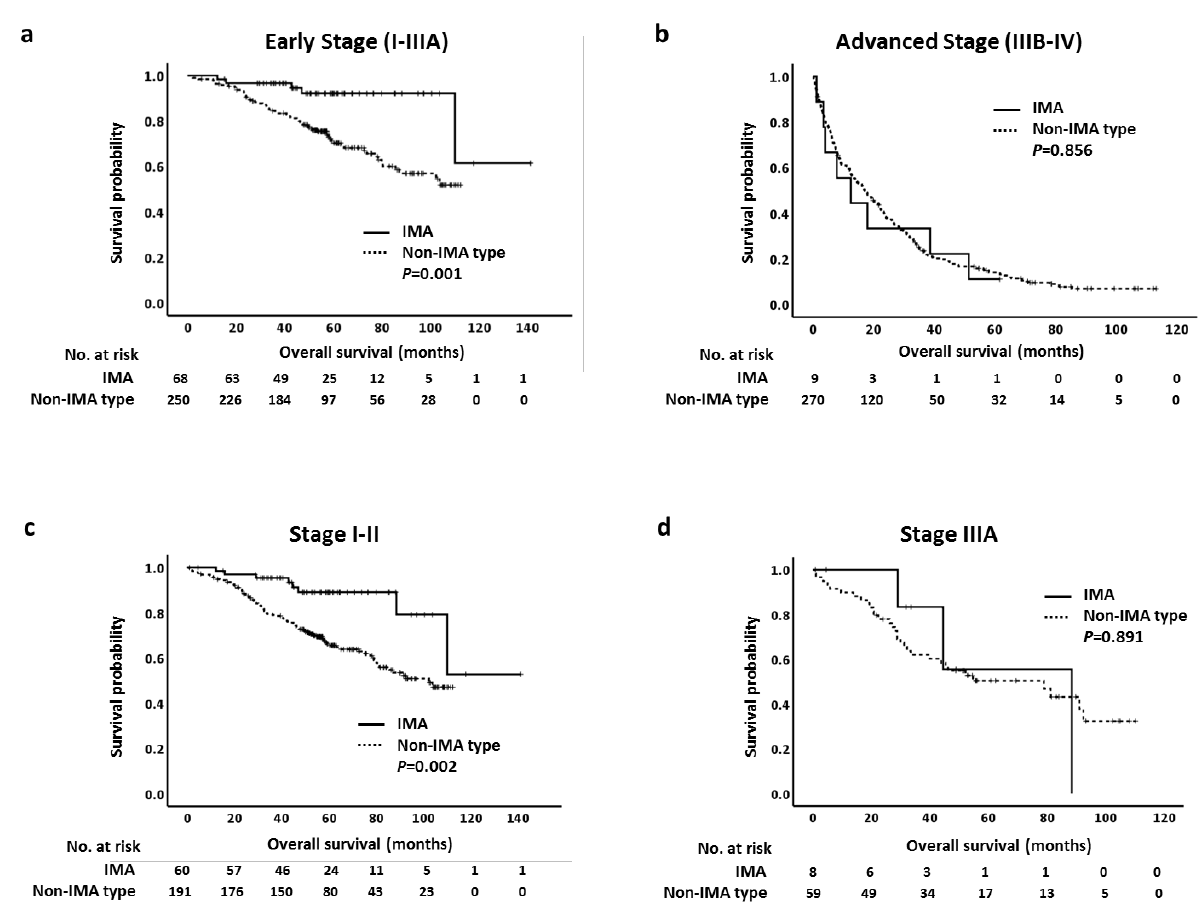
Figure 3. Kaplan – Meier curves of overall survival of different stages in pulmonary invasive mucinous adenocarcinoma (IMA) and non-IMA-type adenocarcinoma. ( a ) Early stage (I – IIIA), ( b ) advanced stage (IIIB-IV), and ( c ) stage I-II, ( d ) stage IIIA.